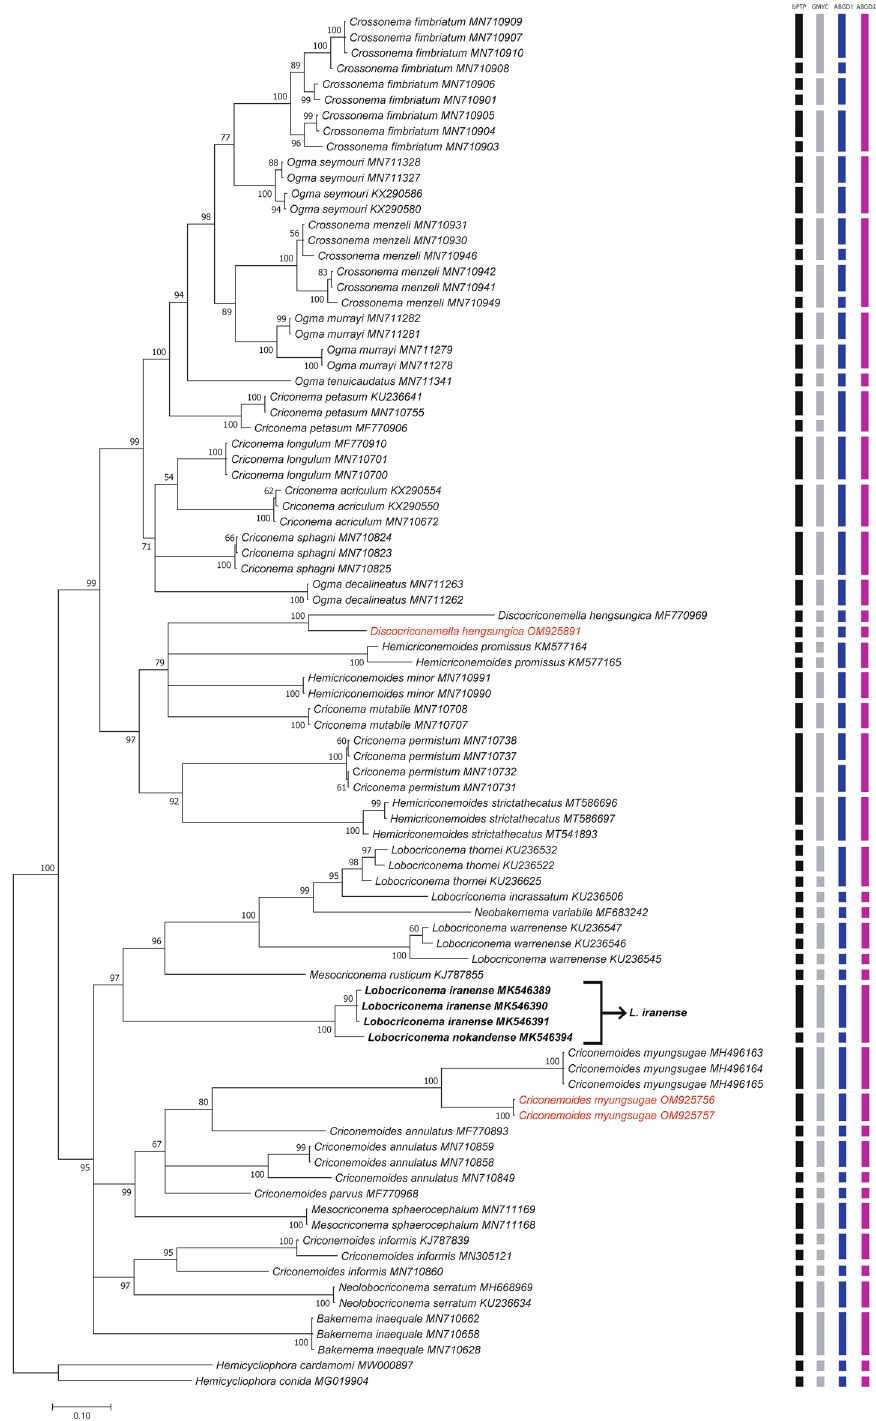
Figure 4. Phylogenetic tree generated from COI mtDNA sequences under GTR + G + I model. Posterior probability (in percentage) was given next to each node. Sequences of nematode populations from Vietnam were marked by red